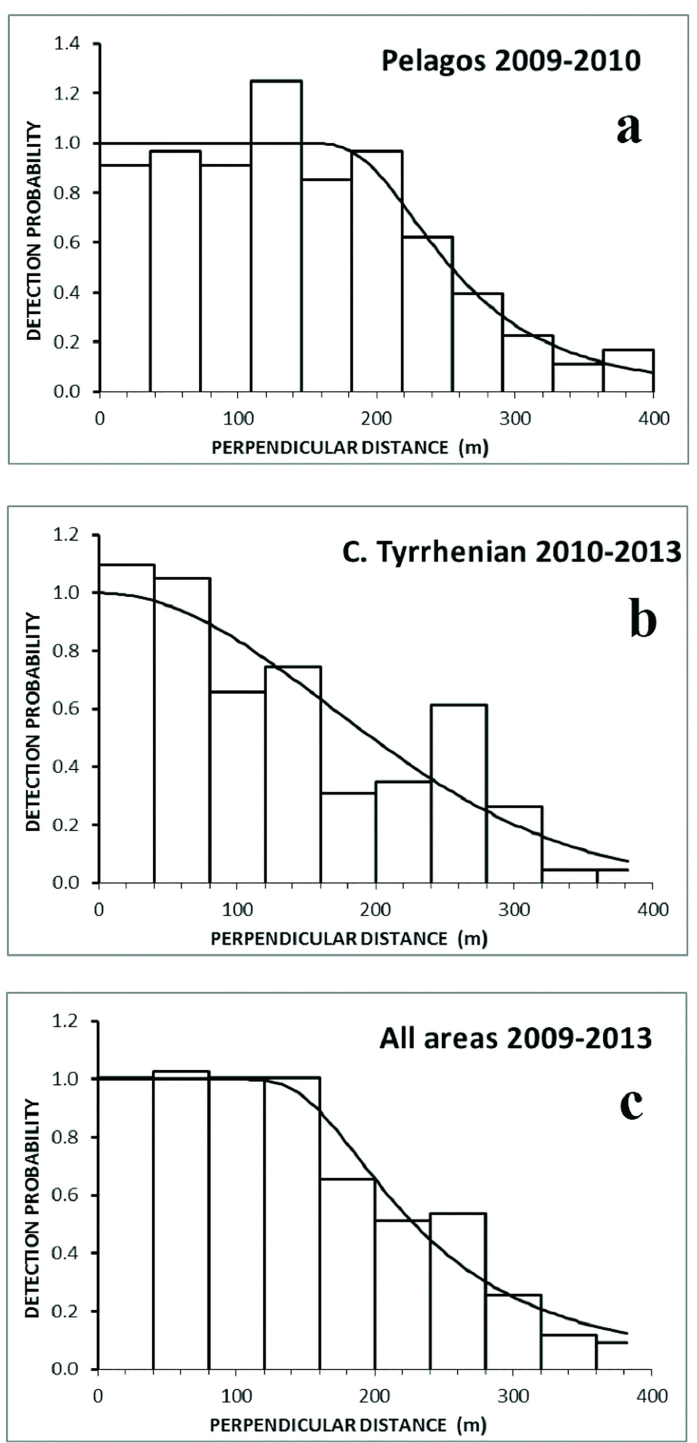
Fig 2. Perpendicular distance distribution (histograms), and fitted detection functions (lines): a) Pelagos Sanctuary, summer, stratified by year, b) Central Tyrrhenian Sea, summer, stratified by year, and c) all summer data pooled (2009, 2010 and 2013) and stratified by